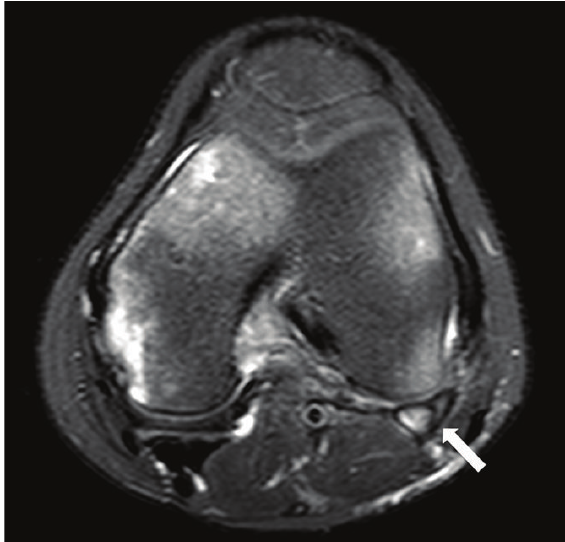
Figure 4: Axial T2-weighted fat-suppressed MRI depicted a low signal line within the fabella consistent with fracture (white